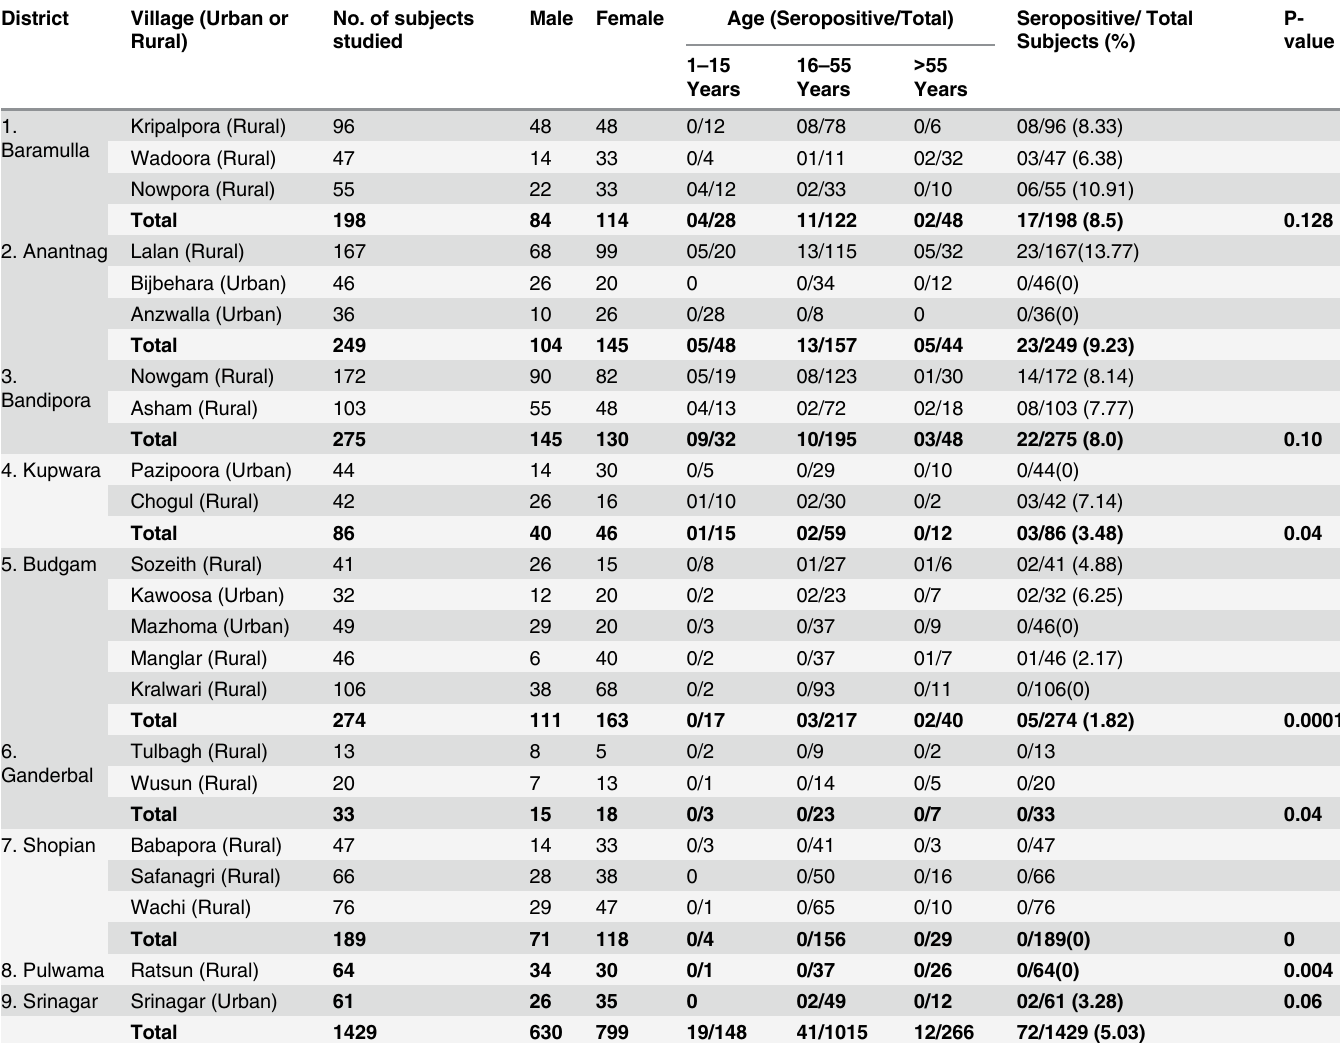
Table 1. District and village wise distribution of demographic characteristics and number of seropositive subjects (N = 1429). District Village (Urban or